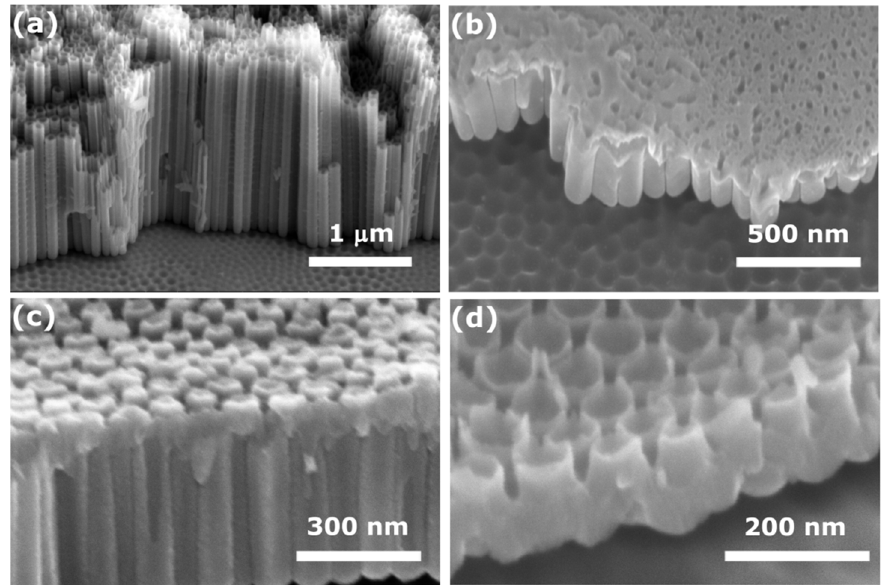
Figure 1. FE-SEM image of the cross-section of: ( a ) TiO 2 -nt; ( b ) TiO 2 -nc; ( c ) TiO 2 -ns assembled on TiO 2 -nc; and ( d ) TiO 2 -nb assembled on TiO 2 -nc synthesized by electrochemical anodization. Table 1. Summary of some geometric parameters of the four TiO 2 nanostructures. Nanostructure Outer Diameter (nm) Inner Diameter (nm) Length (nm) S a (nm) TiO 2 -nt 98 65 1670 20.8 TiO 2 -nc 84 29 250 3.79 TiO 2 -ns/TiO 2 -nc 85 62/22 35 */362 TiO 2 -nb/TiO 2